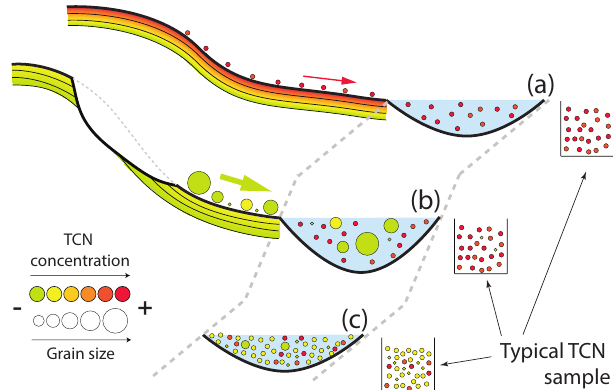
Figure 6. Conceptual diagram illustrating the evolution of the sed- iment 10 Be signal in the Tsangpo-Brahmaputra. (a) Sediments with a high 10 Be concentration are transferred to the channel in the slowly eroding upstream Tibetan part of the catchment. (b) The high-concentration 10 Be flux is diluted by low-concentration sed- iment produced by landslides within the NBGPm region. However, landslides mainly transfer coarse material to the channel so that the sediments sampled within the sand fraction that is typically used for 10 Be measurements is still dominated by material derived from the Tibetan Plateau. (c) Further downstream, abrasion processes trans- fer sediment from the coarse-grained landslide material into the sand fraction so that the denudation signal of the NBGPm is only sampled downstream of the actual location of intense